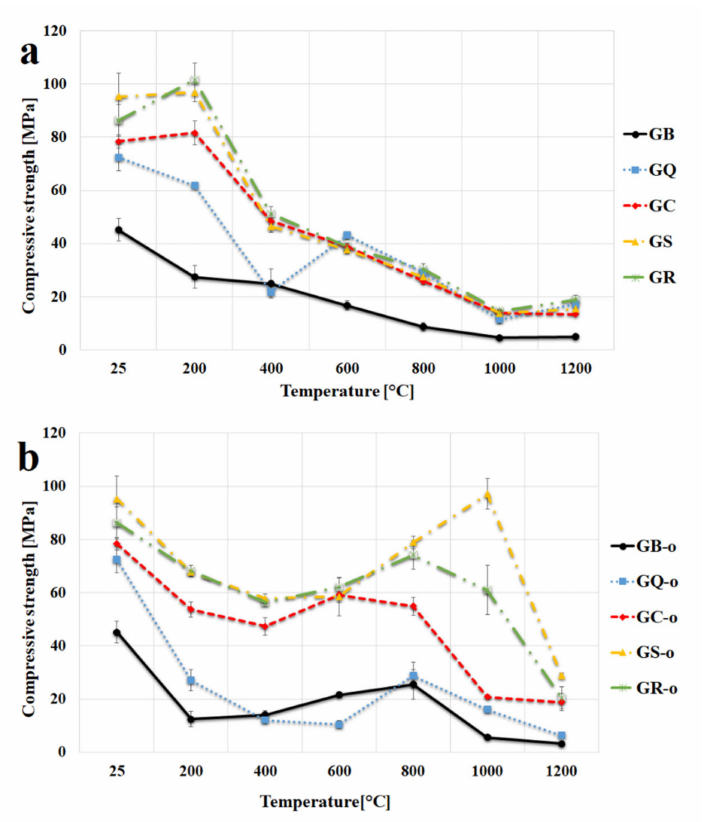
Figure 7. Compressive strength of the geopolymer binder and geopolymer composites at room temperature and after exposure up to 1200 ◦ C ( a ) and in situ temperature from 25 ◦ C to 1200 ◦ C ( b